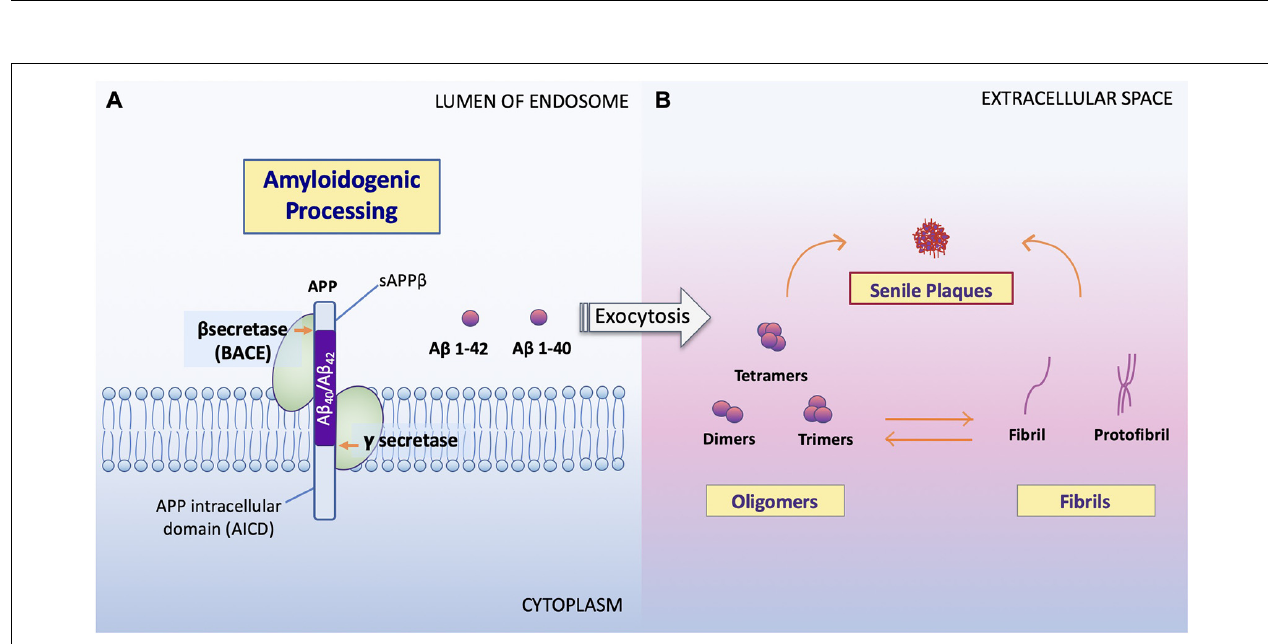
FIGURE 2 | Processing of APP and formation of A β oligomers vs. fibrils. (A) Amyloidogenic processing. Sequence divergence at the internal A β site by γ -secretase produces the monomers A β 1–40 and A β 1–42 (Campion et al., 2016) to be deposited to the extracellular space. (B) A β oligomers vs. fibrils formation. Amyloid oligomers are small with few-chain, soluble, disordered clusters. Fibrils are long, many-chained, highly structured, β -sheet-like aggregates. The hydrophobic amino acids of A β 1–40 and A β 1–42 peptides confer to the hydrophobicity of the C terminal. Fibrils then arrange in a beta-pleated sheet and form the amyloid plaques seen on conventional hematoxylin and eosin (HE) staining or amyloid specific staining (Sun et al., 2015). It has been noted that the high peptide concentration tips the balance towards fibrils regardless of monomer concentrations and that the onset of fibrilization limits the concentration of oligomers in solution (Schmit et al., 2011).